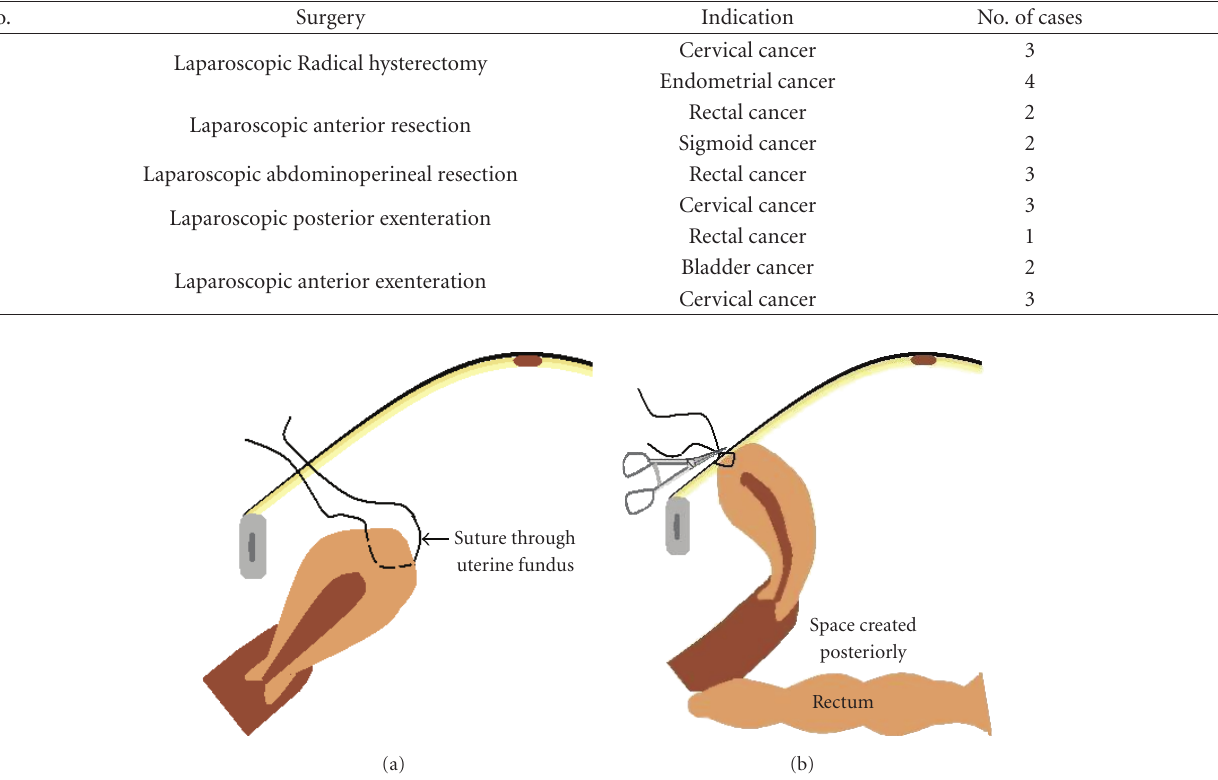
Table 1: List of surgeries where the uterine hitch technique was used.